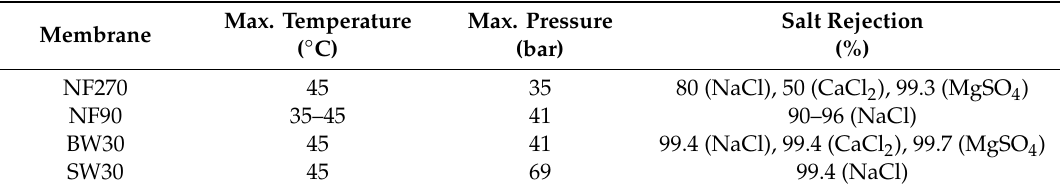
Table 4. Characteristics of the nanofiltration (NF) and reverse osmosis (RO) membranes studied, according to the manufacturers’